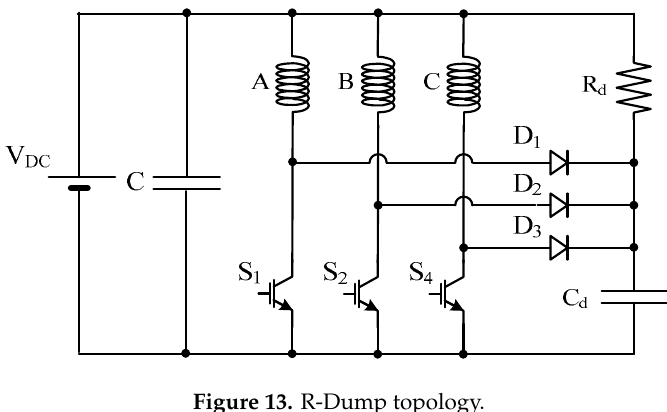
Figure 13. R-Dump topology.